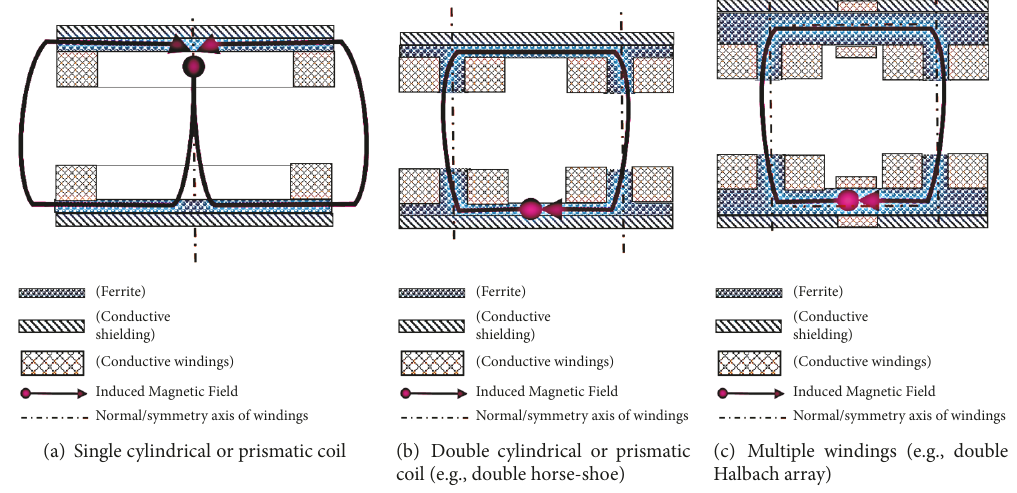
Figure 4: Examples of single phase, planar pads used for inductive power